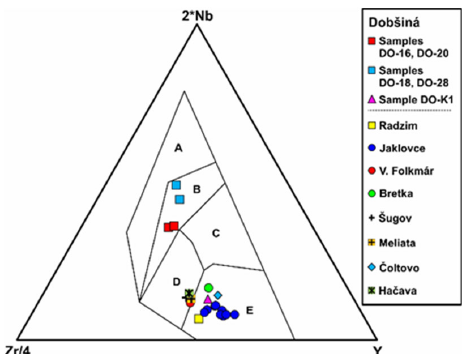
Figure 14. Geotectonic discrimination diagram Zr–Nb–Y [111] for the Meliatic metabasalts. The fields are: A1—within plate basalts, B—within plate alkali basalts and within plate tholeiites; C—E ‐ type MORB; D—within plate tholeiites and volcanic arc basalts; and E—N ‐ type MORB and volcanic arc basalts.